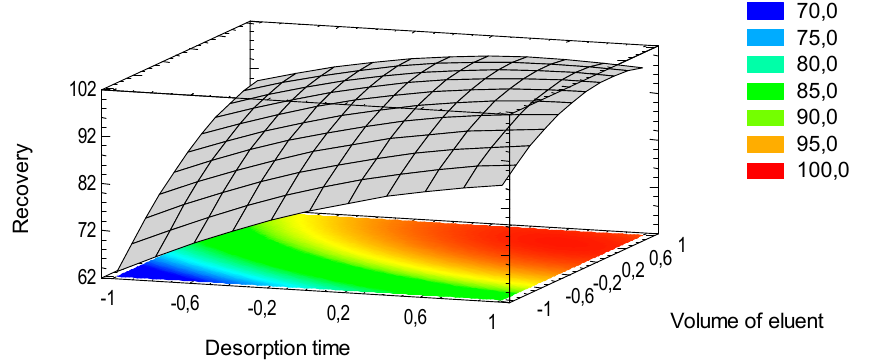
Figure 7. Response surface of the experimental optimization design.